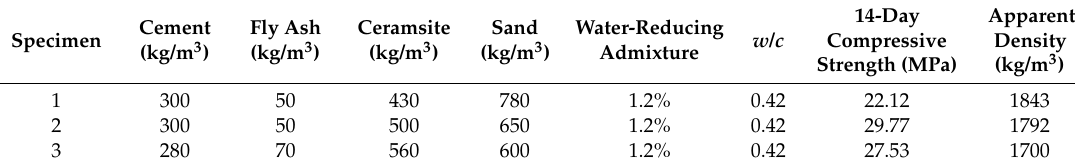
Table 1. Mix proportion design of bricks. w / c : Water cement ratio.